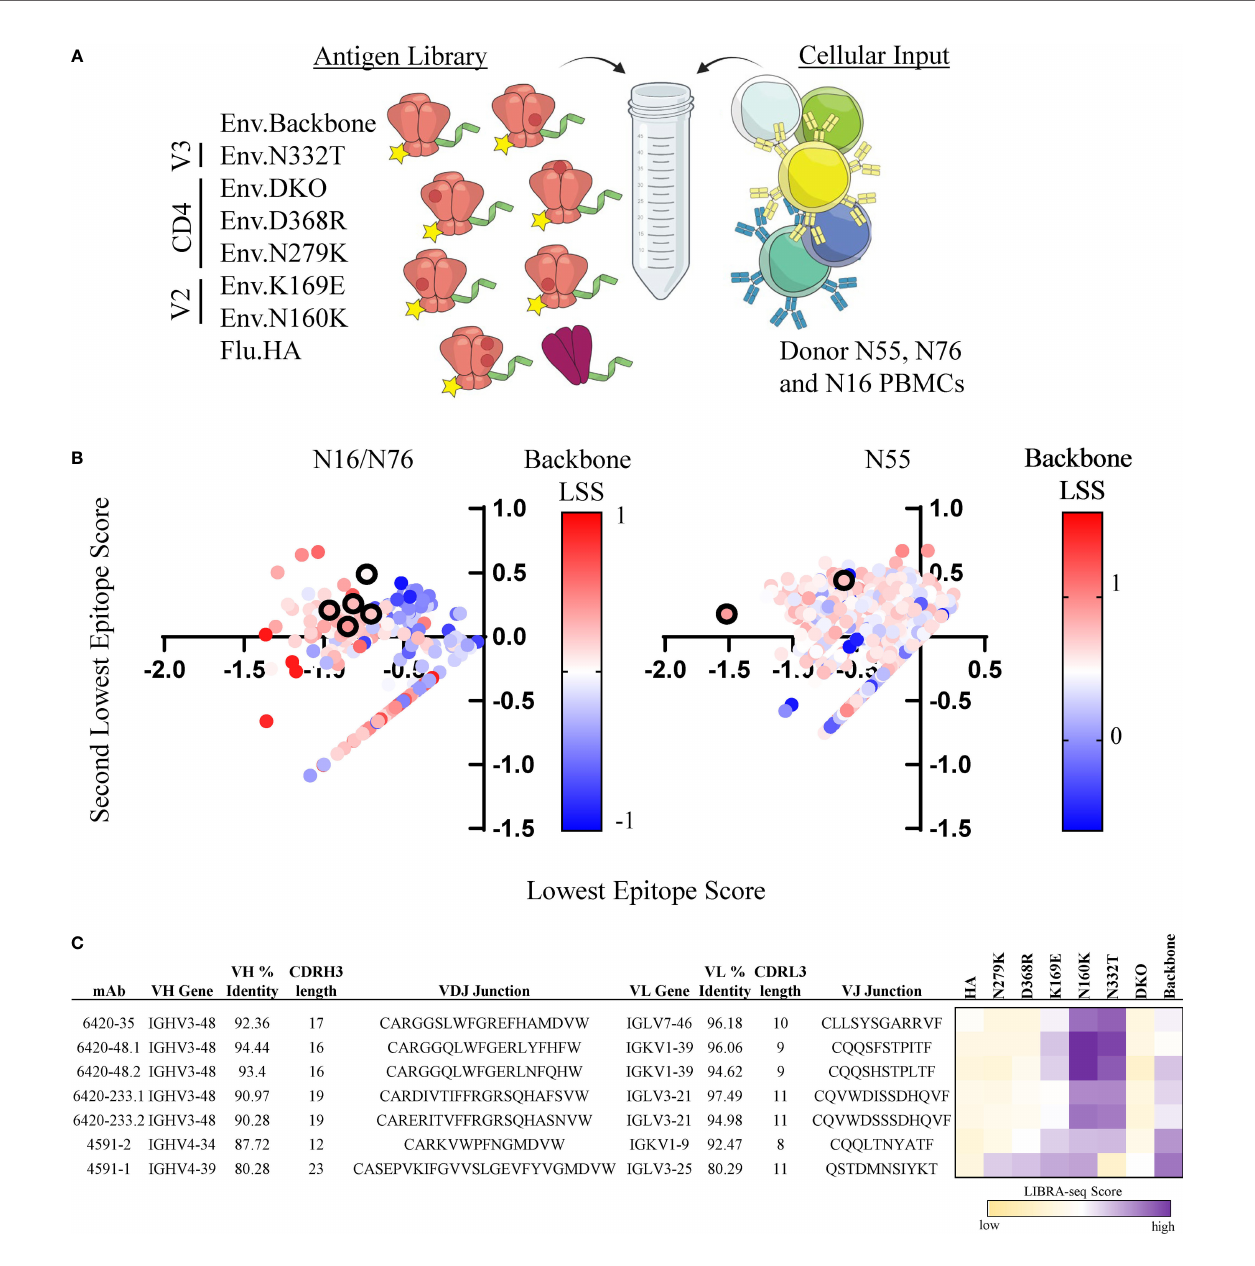
FIGURE 1 | Identi fi cation of CD4bs and V3-glycan site speci fi c antibodies from HIV-1 infected subjects. (A) Schematic of DNA barcoded antigens used in LIBRA-seq with epitope mapping assays. (B) Cells (dots) from experiments 1 (left, donors N16 and N76) and 2 (right, N55) are shown. For a given cell, the minimum LIBRA-seq score among all antigen variants for a given epitope (CD4bs, V3-glycan, V2) was computed, and the lowest (x-axis) and second-lowest (y-axis) epitope scores are plotted. Each dot is colored by the LIBRA-seq score for BG505sc.SOSIP (backbone), from lowest (blue) to highest (red). Antibodies selected for validation are shown in black outline. (C) Sequence characteristics and LIBRA-seq score information for candidate antibodies. Percent identity was calculated at the nucleotide level, and CDR3 length and sequences are displayed at the amino acid level. LIBRA-seq scores for each antigen are displayed on a scale of light